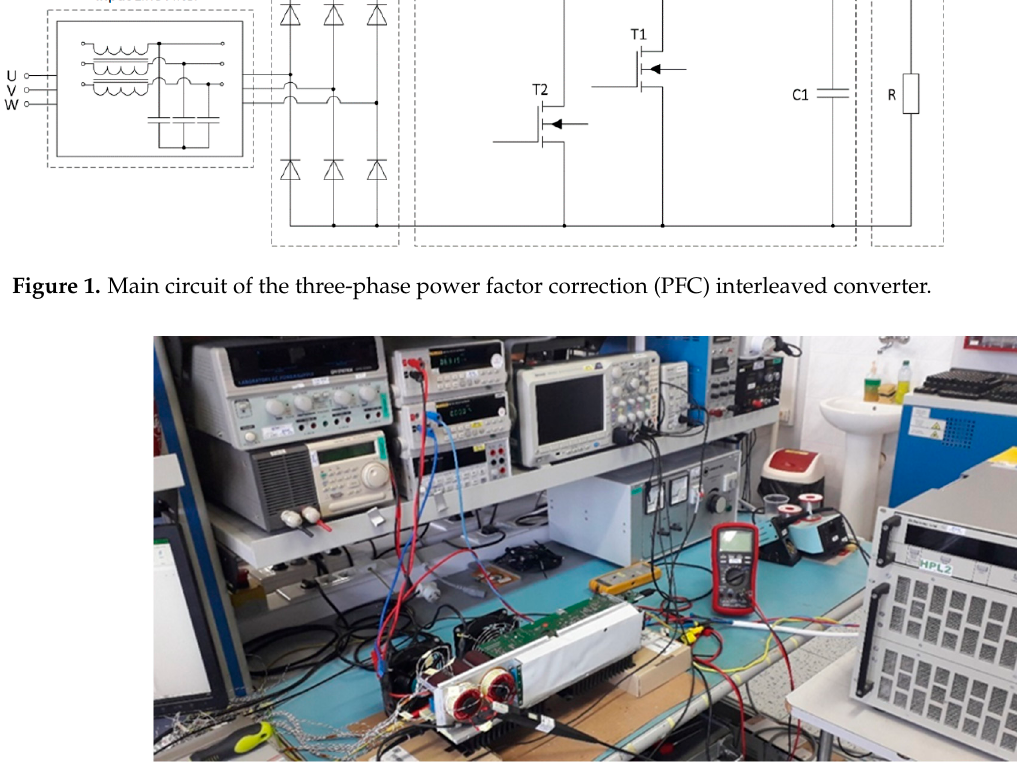
Figure 2. Experimental test-stand for PFC optimization.